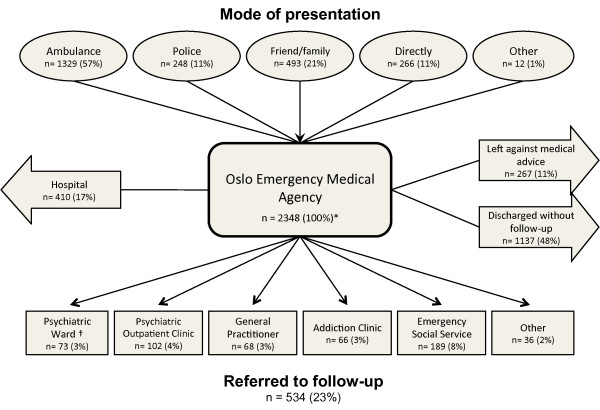
Patient flow in 2348 cases of acute poisoning presenting at the EMA during one year. *Excludes 53 subjects who refused to participate †29 transferred under paragraph of compulsory observation.